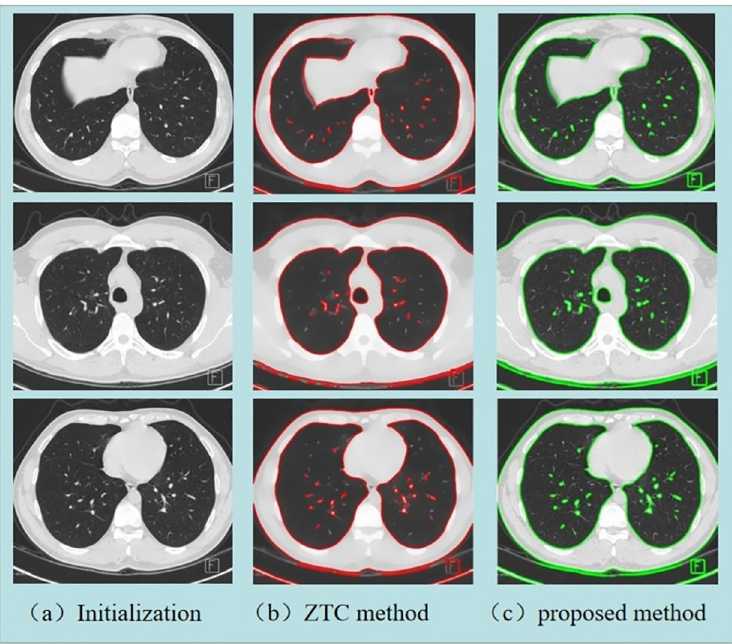
Fig 9. The segmentation results for CT image. (Different from the original picture, it is only for illustrative purposes). https://doi.org/10.1371/journal.pone.0261195.g009 Table 3. The number of iterations to reach convergence (iters) and the total CPU time in seconds (CPU(s)) for different images of different sizes by using our algo- rithm and the ZTC algorithm in the segmentation problem. COVID-9 COVID-82 COVID-1164 ZTC Proposed method ZTC Proposed method ZTC Proposed method CPU(s) iters CPU(s)